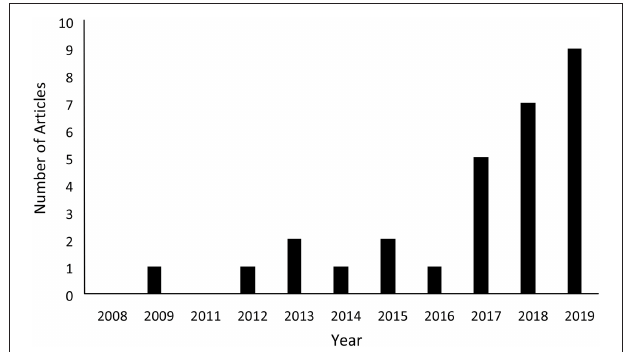
FIGURE 1 | Number of papers published in which movement ecology principles were used to solve specific conservation problems. These data are based on returns from a search of Web of Science for the terms “movement ecology” and “conservation.” The search returned 202 papers, of which 16 were categorized as those in which movement ecology principles were used to solve specific conservation